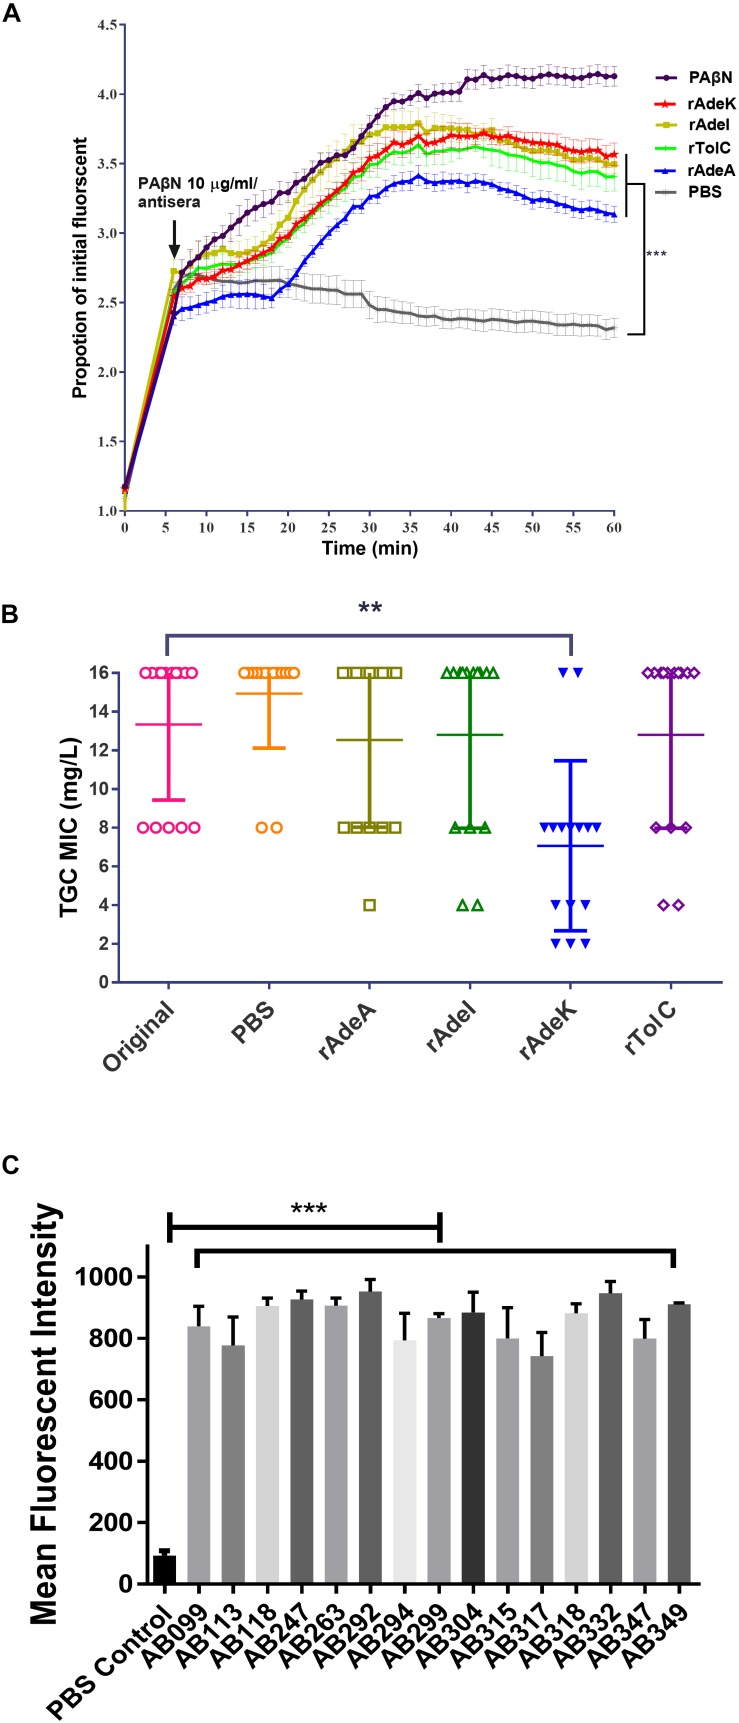
The function of efflux pump inhibition activity of each antiserum. (A) Fold changed-H33342 fluorescence values for ATCC17978 following growth in specific antisera and treatment with phenylalanine-arginine beta-naphthylamide (PAβN) (10 μg/mL). Mock-treated cells are also shown (gray line). The assays were performed in triplicates and the error bars show the SEM at 1-min intervals. (B) Minimum inhibitory concentration (MIC) of tigecycline-resistant (TGC-R) A. baumannii clinical isolates (n = 15) compared to original or specific antisera [phosphate-buffered saline (PBS), rAdeA, rAdeI, rAdeK, and rTolC] co-administrated by broth microdilution method. The experiments were performed in triplicates. The p-value was determined by Kruskal–Wallis test with Dunn’s multiple comparison analysis. **p < 0.01. (C) Histogram representing quantitative analysis of the binding intensity between anti-AdeK antisera and isolates from the FACS study. The bars indicate the means of at least three independent experiments ± SEM. ***p < 0.001.